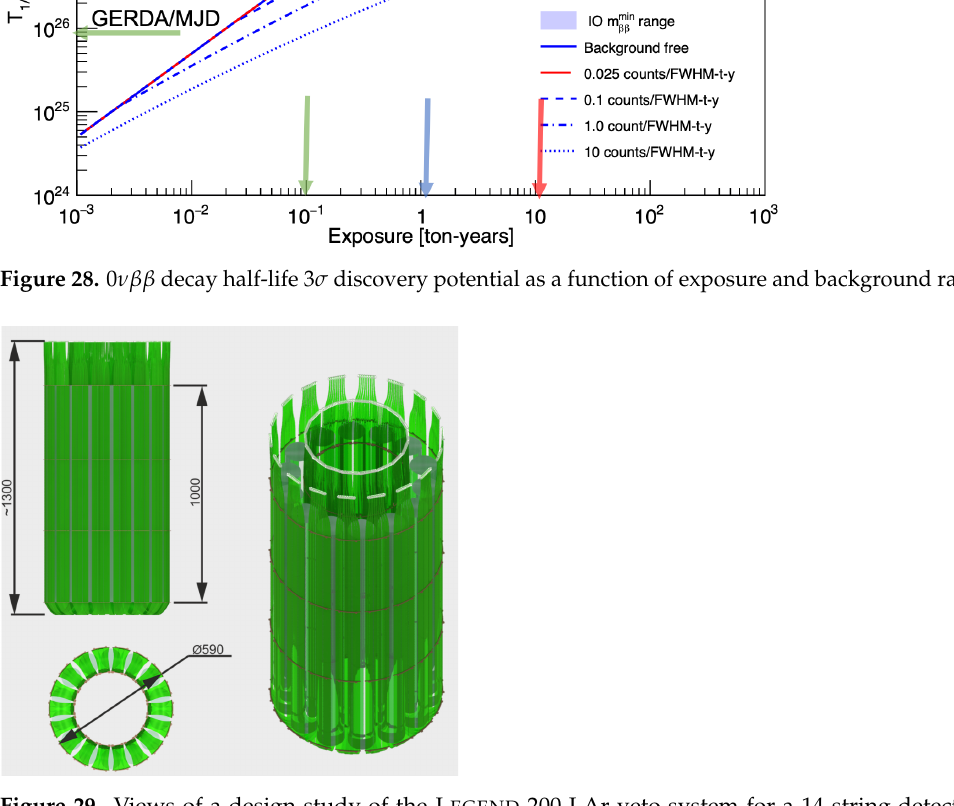
Figure 29. Views of a design study of the L EGEND -200 LAr veto system for a 14-string detector configuration.